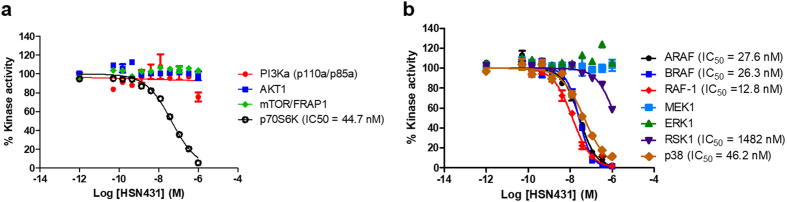
In vitro kinase inhibition by HSN431. The dose-response curves obtained by incubating increasing concentrations of HSN431 with kinases in the (a) PI3K/AKT/mTOR pathway and (b) MAPK pathway. ATP concentration was 100 μM. Refer to Table S1 for concentrations of kinases and corresponding substrates. Each data point represents the mean ± SD of duplicate measurements.